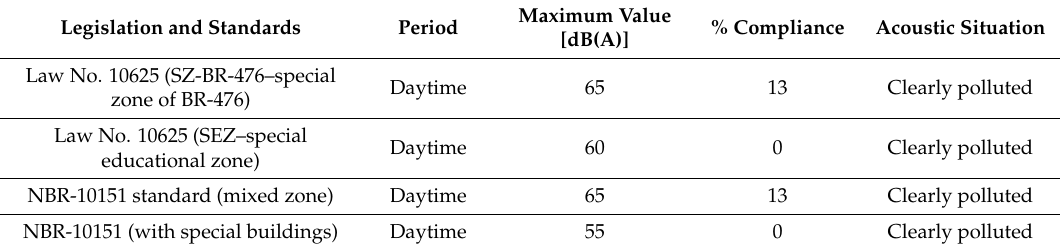
Table 9. Comparison of maximum acceptable values, implementation phase, daytime.